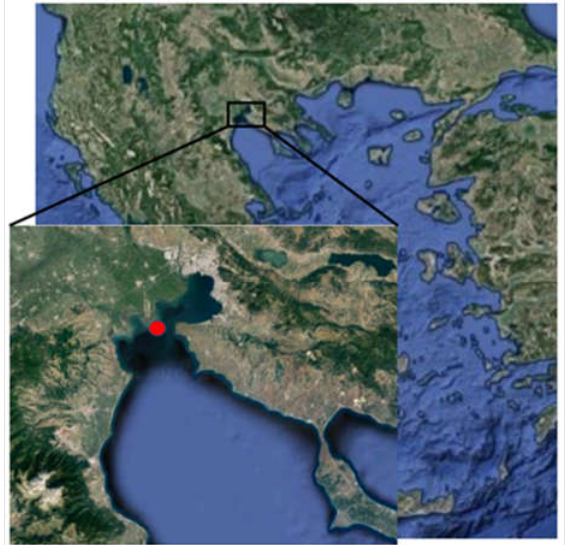
Figure 2. Balcanic peninsula including Greece. Sampling site (red dot) Kimina site (40.474678, 22.723543) of both sampling techniques.